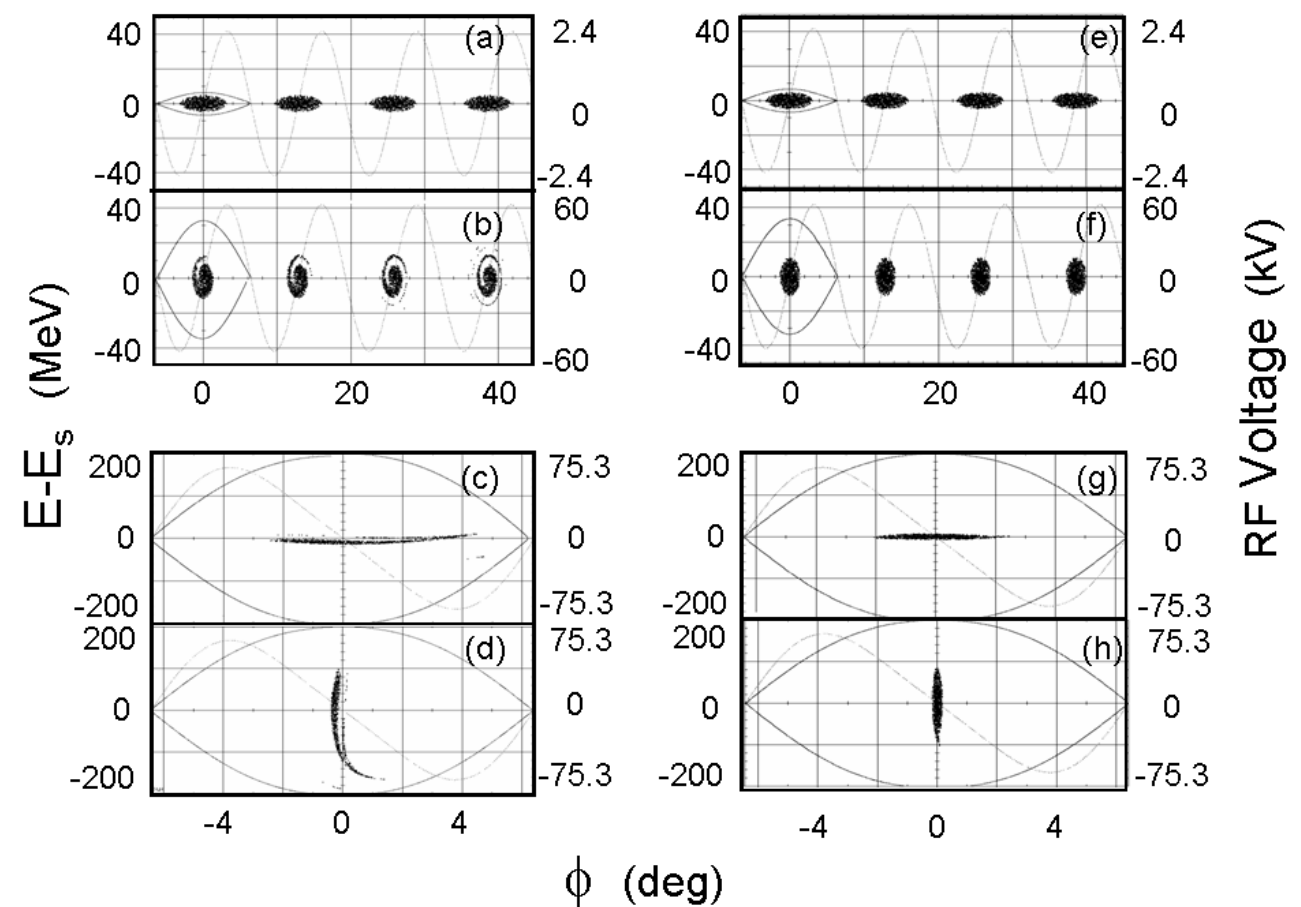
FIG. 3. Simulated (cid:2) (cid:1) E; (cid:1) (cid:5) (cid:3) -phase distribution of antiprotons without (left column) and with (right column) BLC for 1.3 eV s (95%) bunches. (a) Four bunches of 6 (cid:7) 10 10 particles = bunch at 9 GeV immediately after the injection. (b) A few seconds after injection, still at 9 GeV. (c) Beam at 27 GeV before bunch rotation (first bunch only) and (d) after bunch rotation (first bunch only). This clearly shows significant bunch mismatch and one expects significant emittance growth. The simulations with BLC for 17 (cid:7) 10 10 particles = bunch shown in (e)–(h) indicate little phase-space